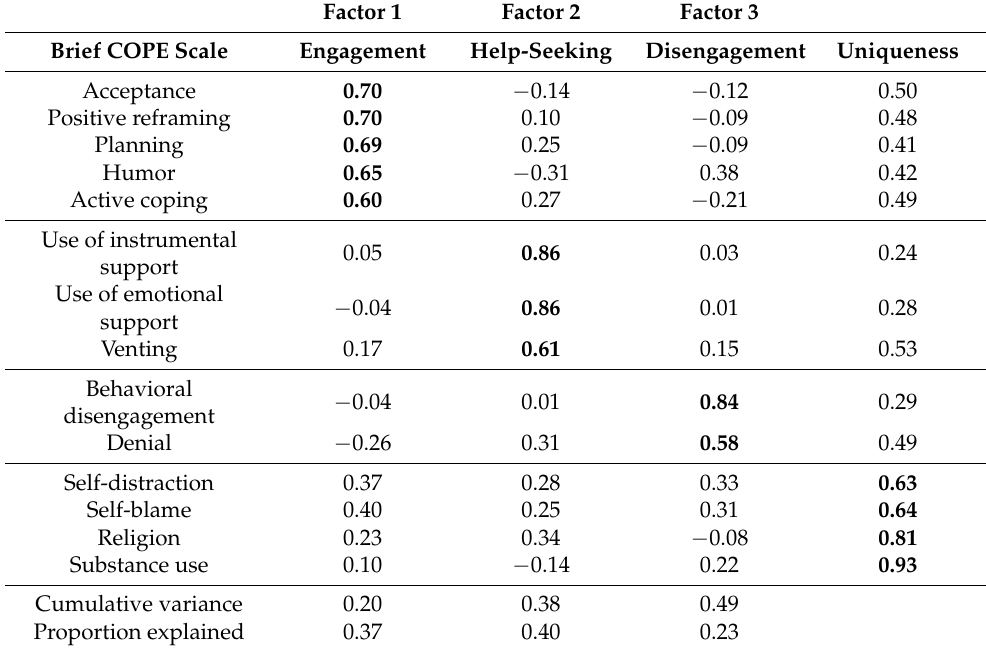
Table 2. High-order factor structure of the Brief COPE scales. Factor 1 Factor 2 Factor 3 Brief COPE Scale